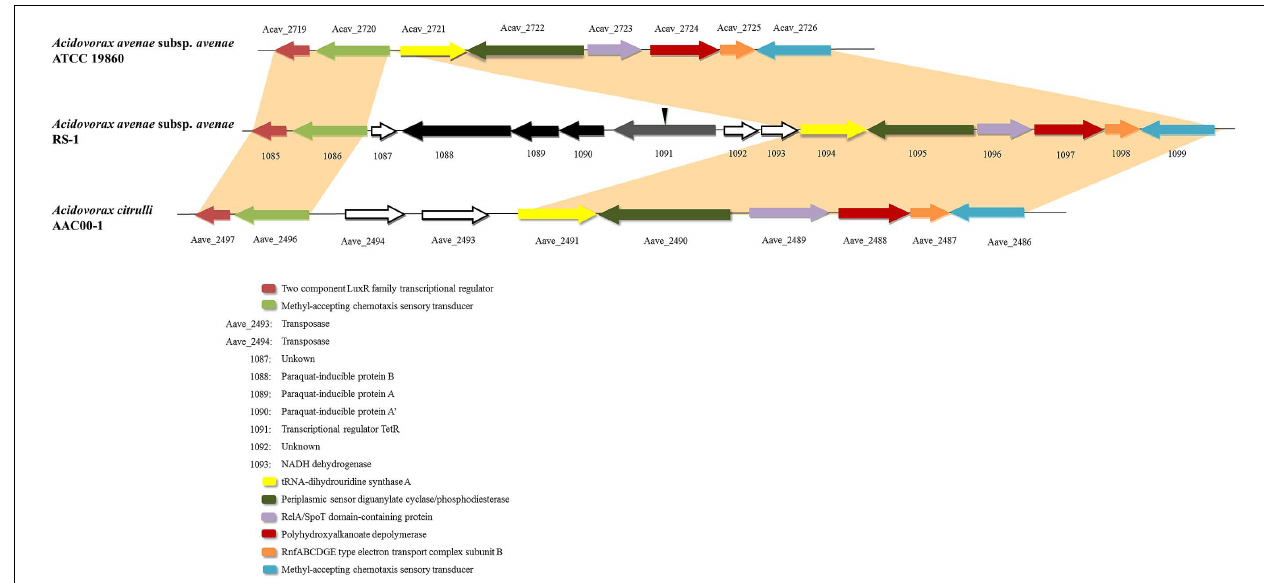
FIGURE 1 |Alignment of Acidovorax avenae subsp. avenae RS-1, ATCC 19860 and A. citrulli AAC00-1 chromosomes. One cluster was found in RS-1 containing four genes including tetR and pqiAA’B . Sequences from this cluster with upstream and downstream sequences were aligned with